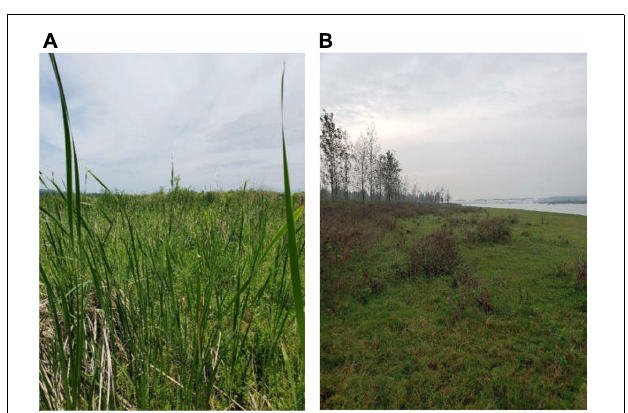
FIGURE 2 | (A) Typical riparian vegetation upstream of a dam [the sample site of Lihuahu (LHH), June 06, 2019]; (B) typical riparian vegetation downstream of a dam [the sample site of Nanhu (NH), October 23,